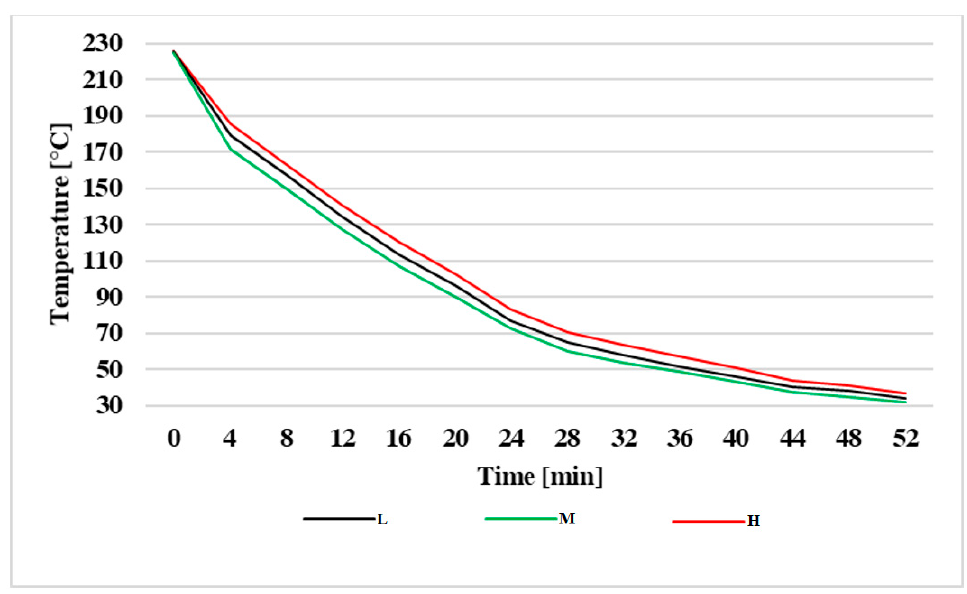
Figure 15. Brake pads’ temperature in the section of contact with brake disc. The temperature of the mid-priced brake pads decreased fastest. The slowest reduction in temperature was seen in high-priced pads (Figure 15). The maximum difference in temperature was 14 ◦ C, which is a relatively low value.